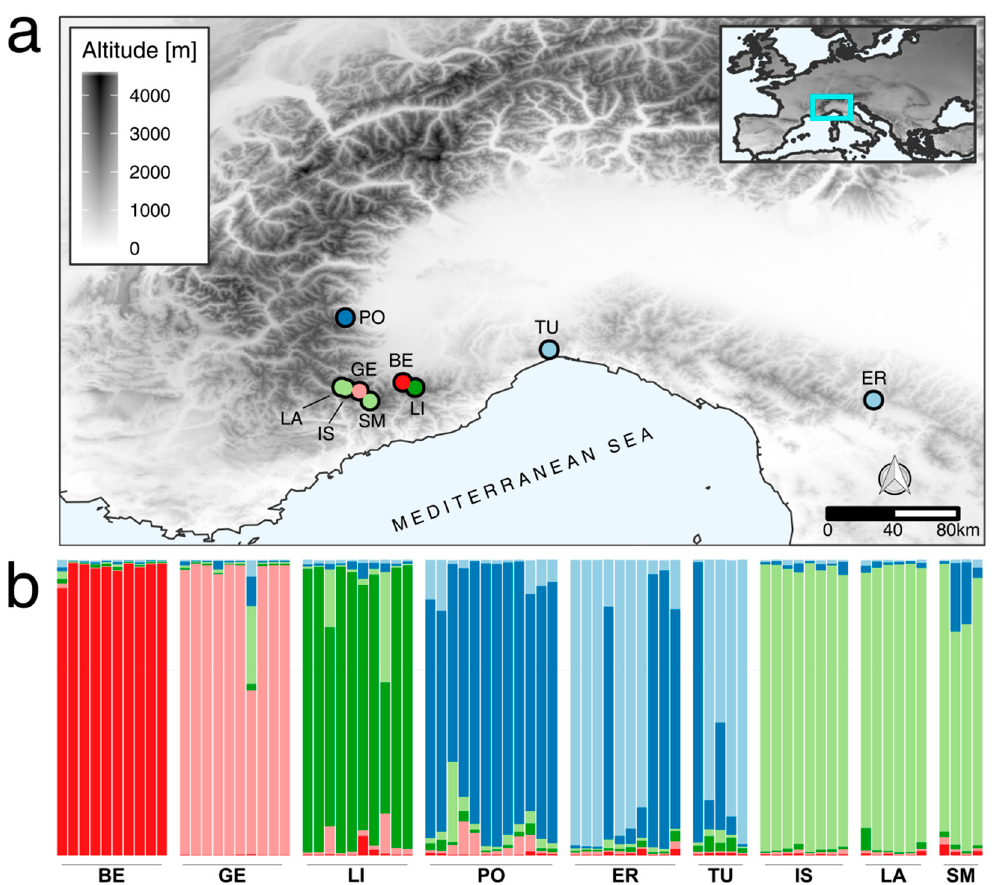
Figure 1. Geographic framework and STRUCTURE analysis results: ( a ) SCoTs genotyped populations across the species range. Background grey scale represents altitudes. Each dot corresponds to a studied population in its geographical position and dot colors correspond to the most probable cluster (K) retrieved by means of the STRUCTURE analysis. Dot color code and STRUCTURE analysis color code match. ( b ) results of the STRUCTURE analysis for K = 6 as determined with Structure Harvester in Evanno hypothesis. LA, IS, SM, and GE populations were from Maritime Alps; LI and BE were from Ligurian Alps; PO was from Cottian Alps and TU and ER were from Appennines. See Table 4 for populations details.